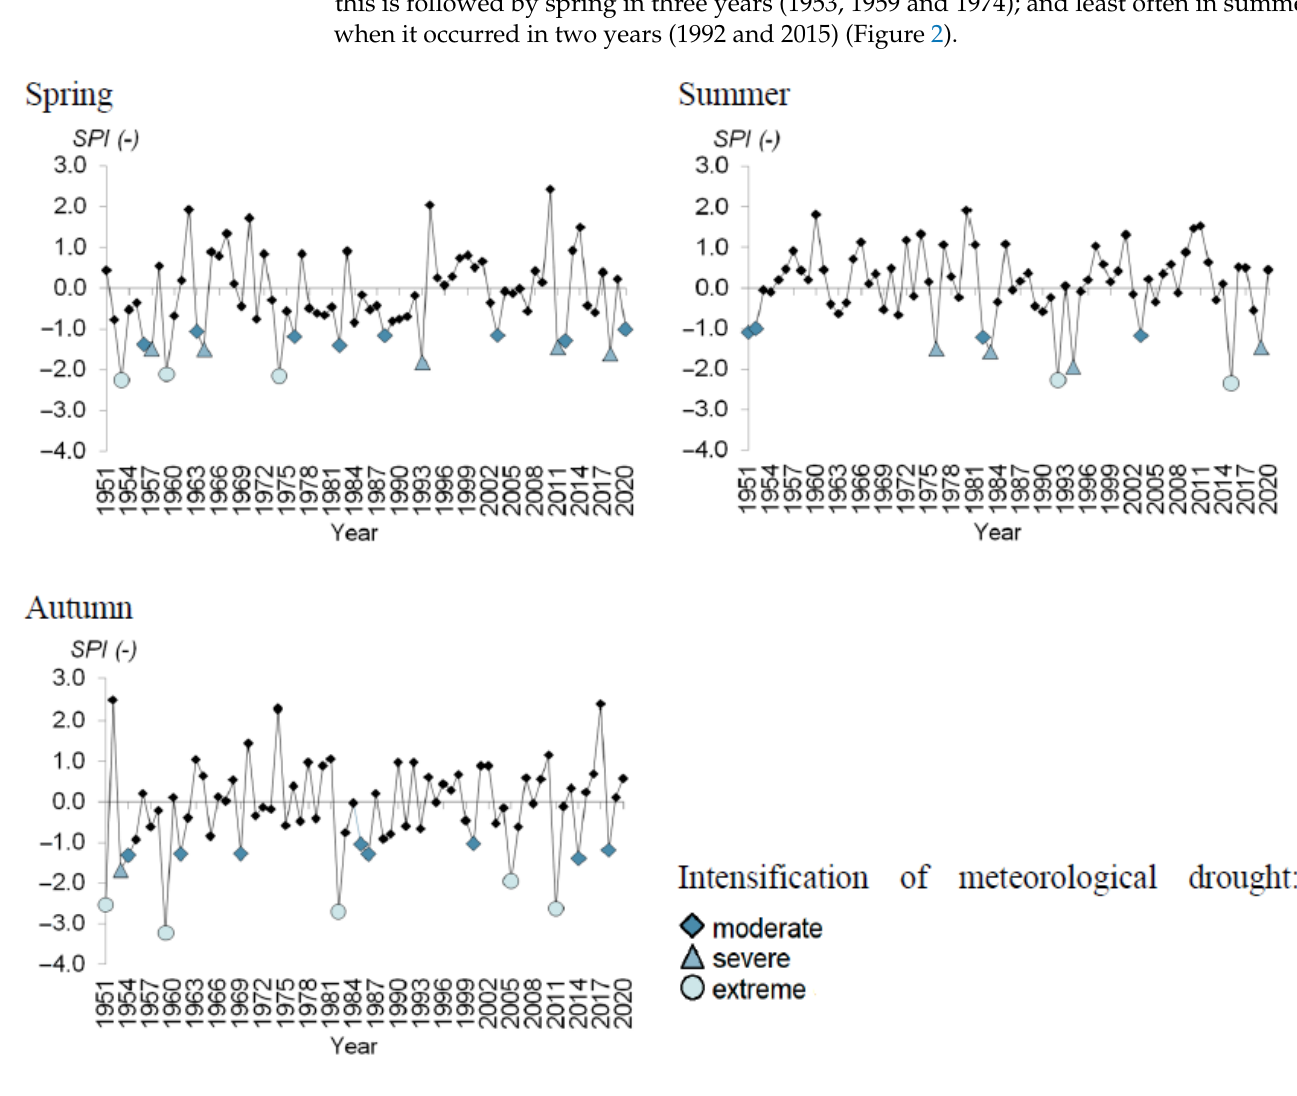
Figure 2. Variations in SPI-3 for whole of Poland in spring, summer and autumn. Years 1951–2020.